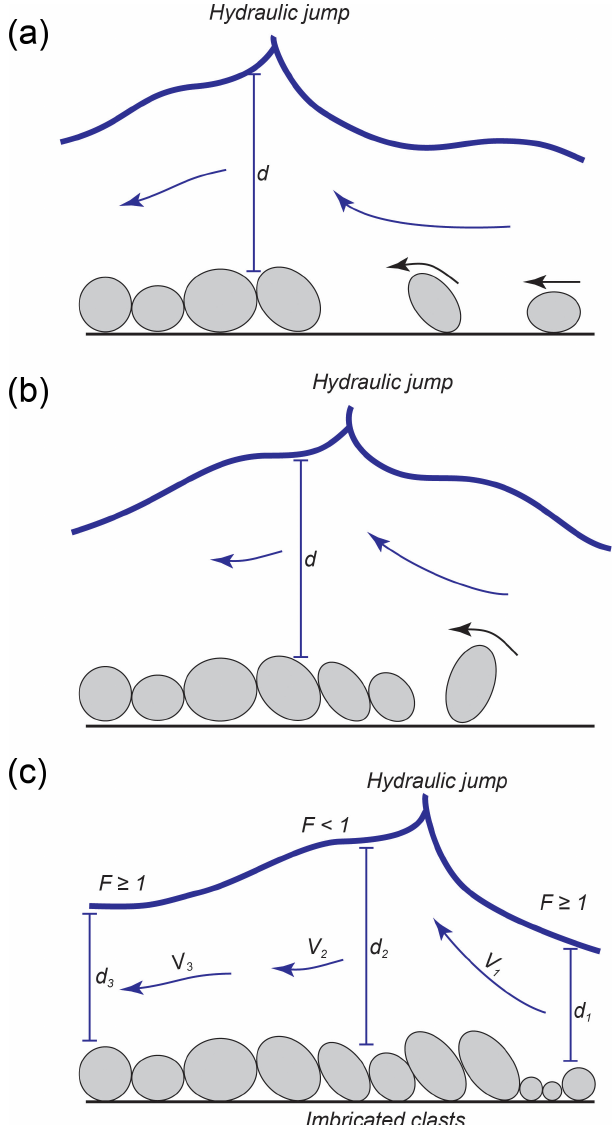
Figure 8. Conceptual sketch illustrating the formation of an ensem- ble of imbricated clasts as time proceeds ( a through c ). According to this model, the site of sediment accumulation will migrate up- stream. F is the Froude number; v is the flow velocity; d is the water